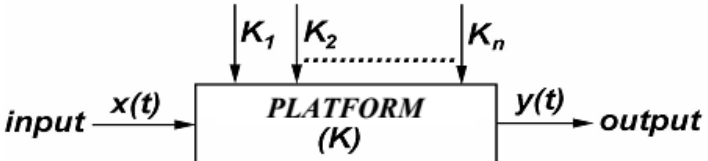
Figure 4. Structure scheme of an open system E-P-WP (environment-platform-working parameters).